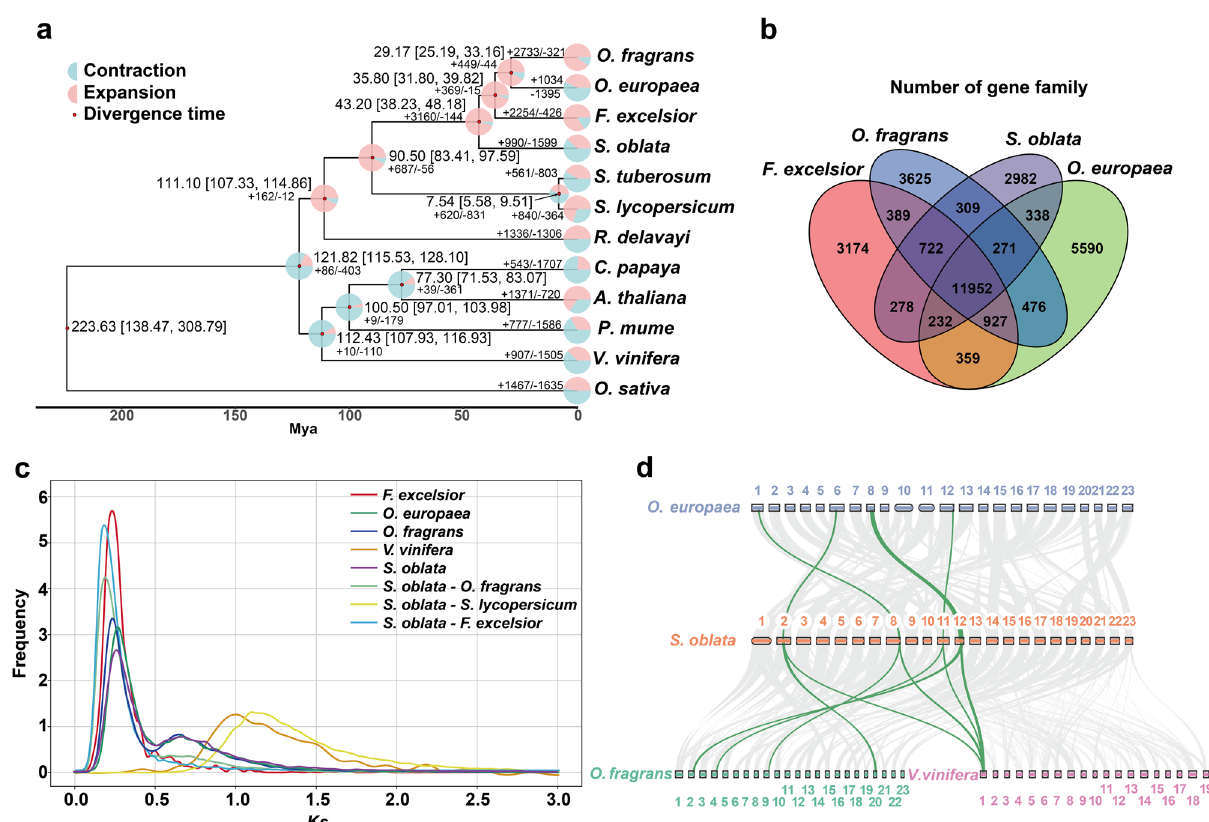
Fig. 2 Lilac genome evolution. a Phylogenetic tree, gene family expansions/contractions in lilac and 11 other species based on a concatenated alignment of 356 single-copy orthologs, and divergence times. b Venn diagram illustrating the shared and unique gene families among S . oblata and three Oleaceae plants ( O . europaea , F . excelsior , and O . fragrans ). c Ks distribution of S . oblata , F . excelsior , O . europaea , O . fragrans , S . oblata - F . excelsior , S . oblata - O . fragrans , S . oblata - S . lycopersicum and V . vinifera . d Chromosome collinearity analysis among lilac, O . europaea , O . fragrans and V . vinifera . Green lines represent four syntenic blocks in lilac match up to one region in V . vinifera